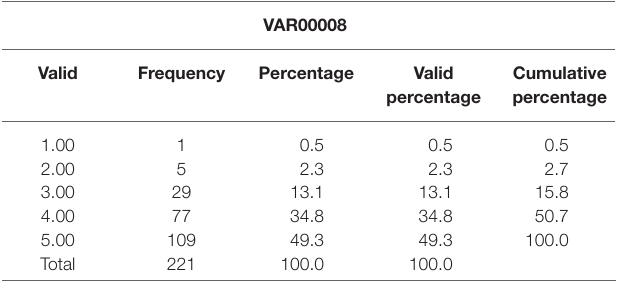
TABLE 8 | Activity has motived me because I have been able to be responsible for my own